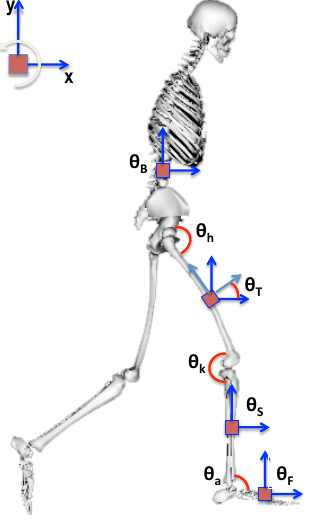
Figure 2. Inertial measurement units (IMUs) attached to the